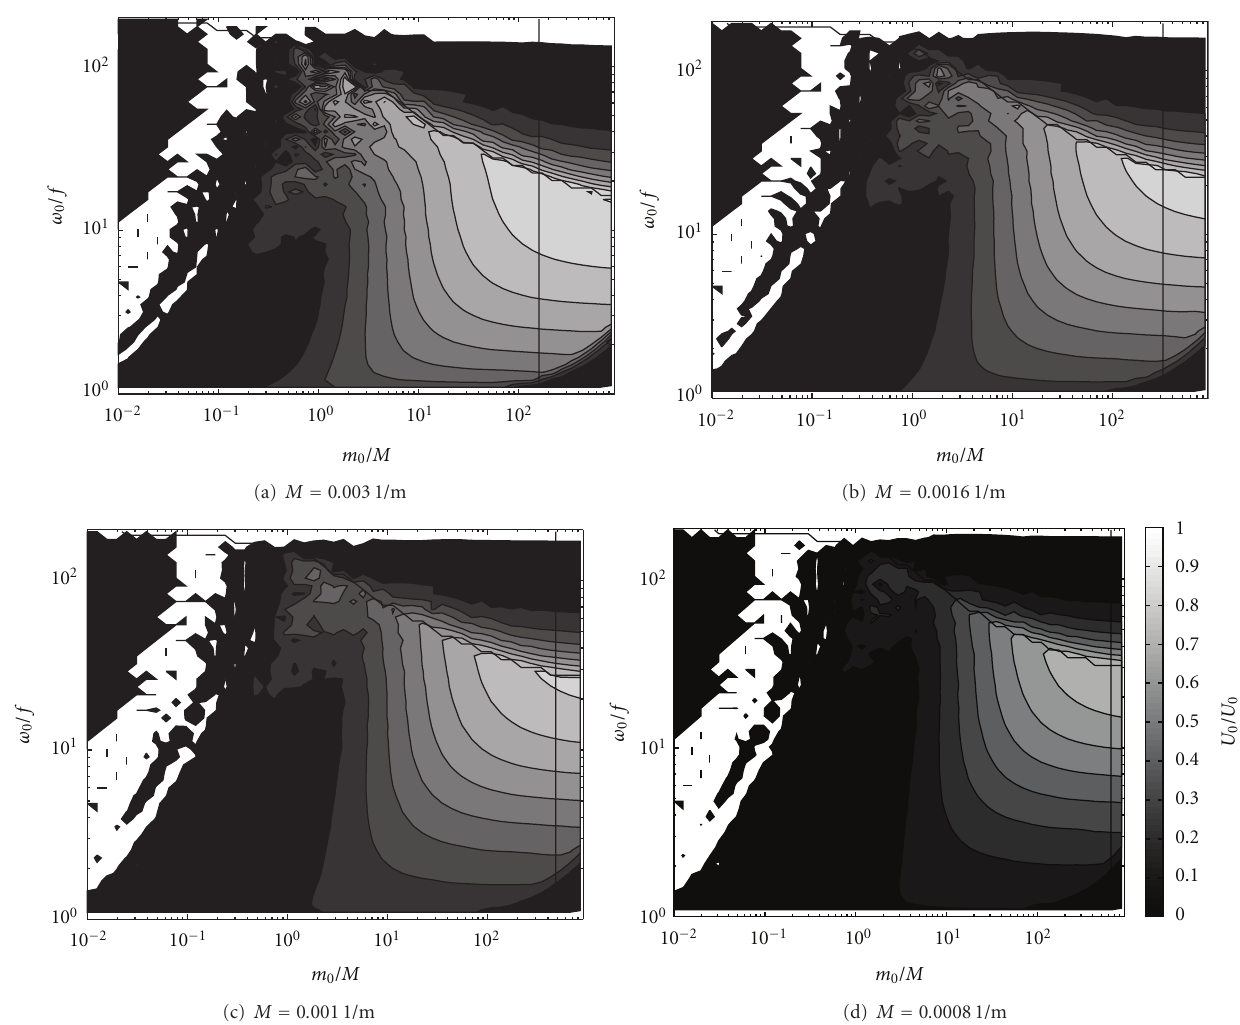
Figure 9: Maximum change in U zero for an interaction with an inertia wave envelope with 5 m/s maximum horizontal velocity and varying M